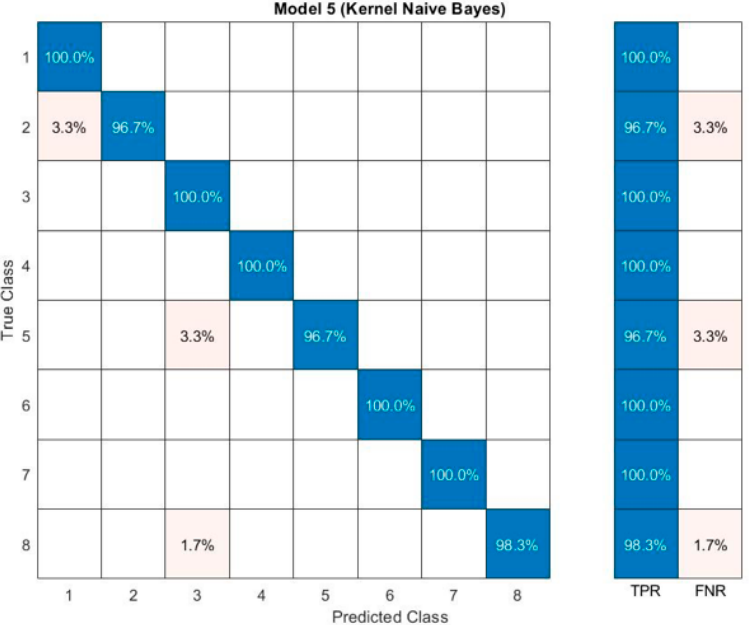
Figure 11. Kernel-Naïve-Bayes-model confusion matrices.